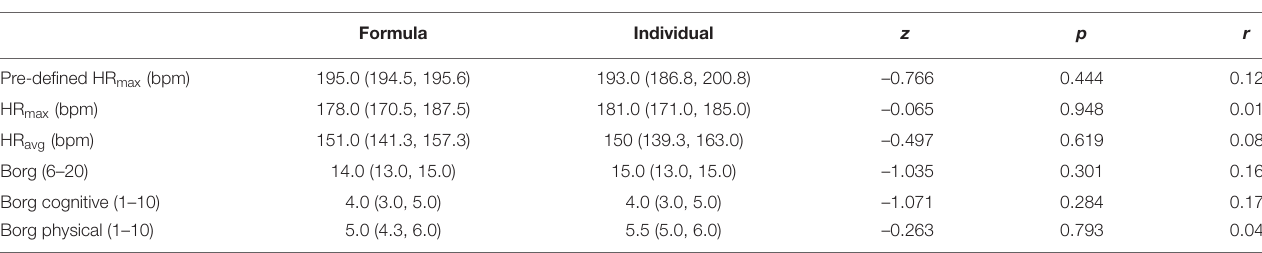
TABLE 3 | Comparison of ExerCube conditions (formula vs. individual) for heart rate and perceived exertion. Formula